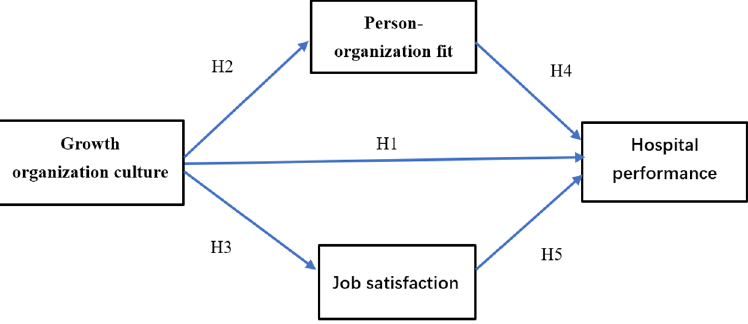
Figure 1. Conceptual model.